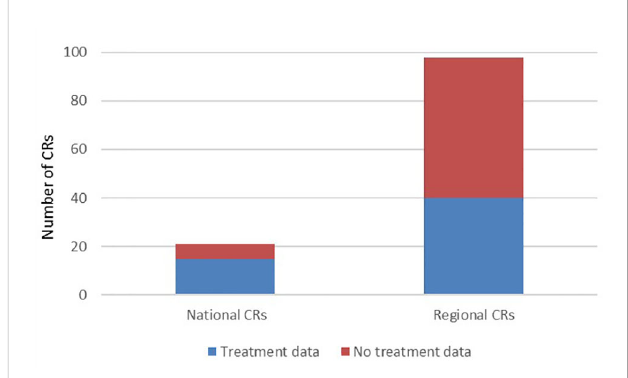
FIGURE 6 Number of general CRs reporting the recording of treatment